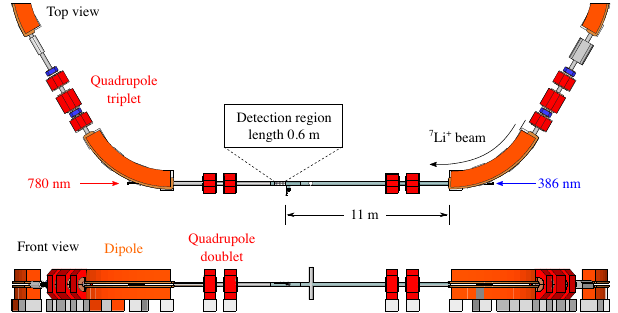
FIG. 2. Top-view and front view of the straight section of the ESR where the laser and the ion beam are superimposed. The lasers are directed through the viewports at the 60°-dipole magnets to co- and counterpropagate with the ion